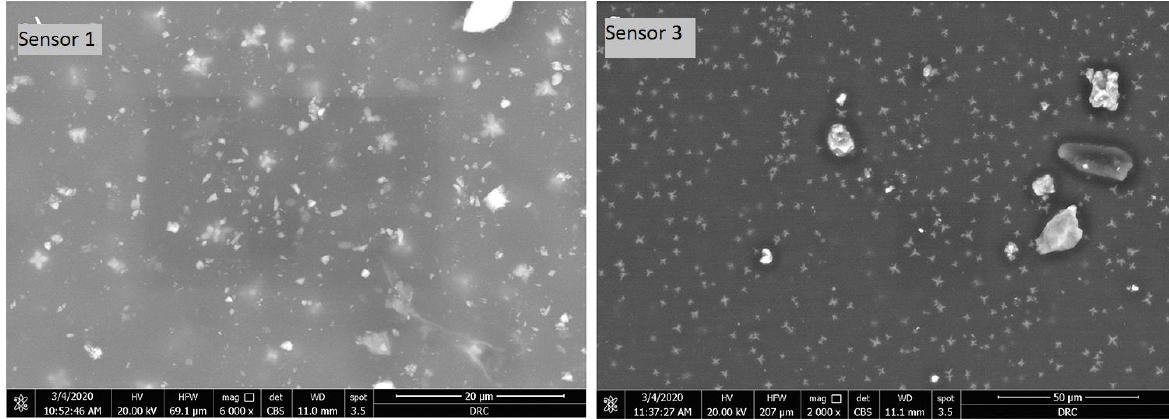
Fig. 6. Scanning electron microscope images for the membranes fabricated; (a) sensor 1, (b) sensor 3. Table 1. Results obtained over a period of two months for the suggested three sensors